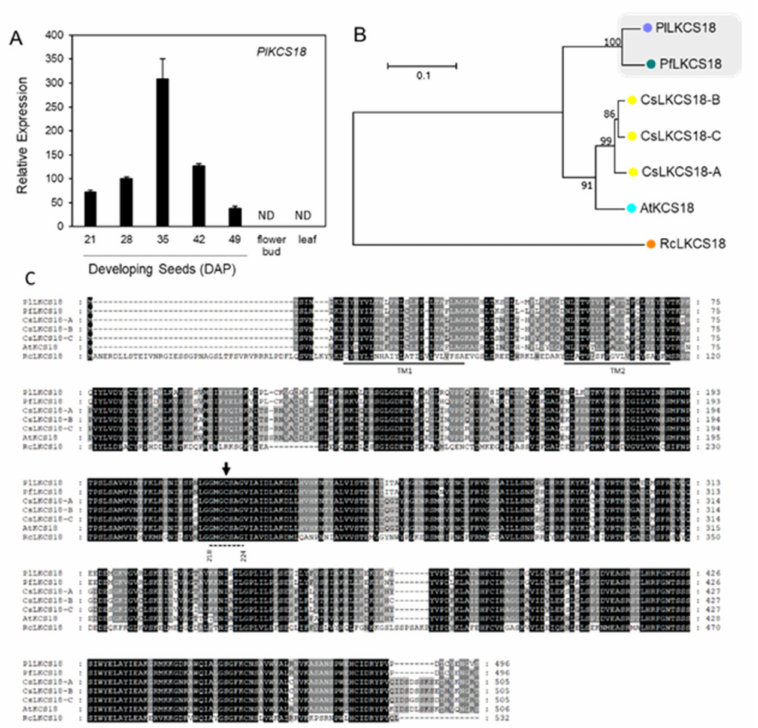
Figure 6. Characterization of KCS18 proteins. ( A ) Relative expression of PlKCS18 by qRT-PCR. DAP, days after pollination. ( B ) Phylogenetic tree of KCS18 proteins from various species. Pl, Physaria lindheimeri ; Pf, Physaria fendleri ; At, Arabidopsis thaliana ; Cs, Camelina sativa ; Rc, Ricinus communis . ( C ) Amino acid alignment of KCS18 proteins. Putative transmembrane domains were underlined. Conserved region (dash-underlined between Gly218 and Gly224) containing an active Cys site among all KCS enzymes [71] was indicated by the arrow. Genbank accession numbers were listed in Supplementary File 6, Table